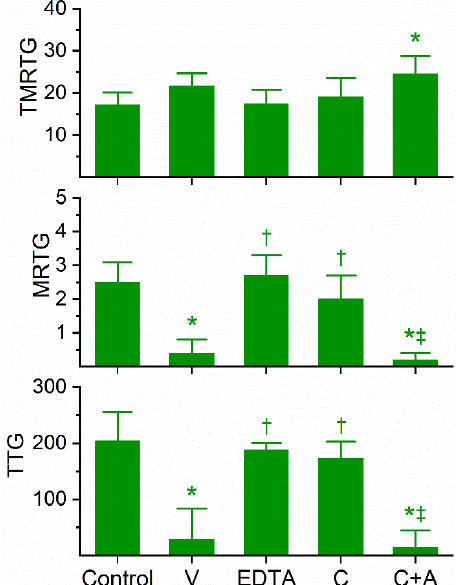
Figure 2. Anticoagulant activity of D. angusticeps venom in human plasma and effects of EDTA and CORM-2 on venom activity. Data are presented as mean ± SD. TMRTG = minutes; MRTG = dynes / cm 2 / sec; TTG = dynes / cm 2 . Control = No additives; V = 3 µ g / mL final